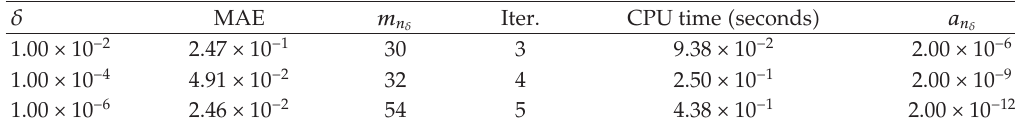
Table 11: Example